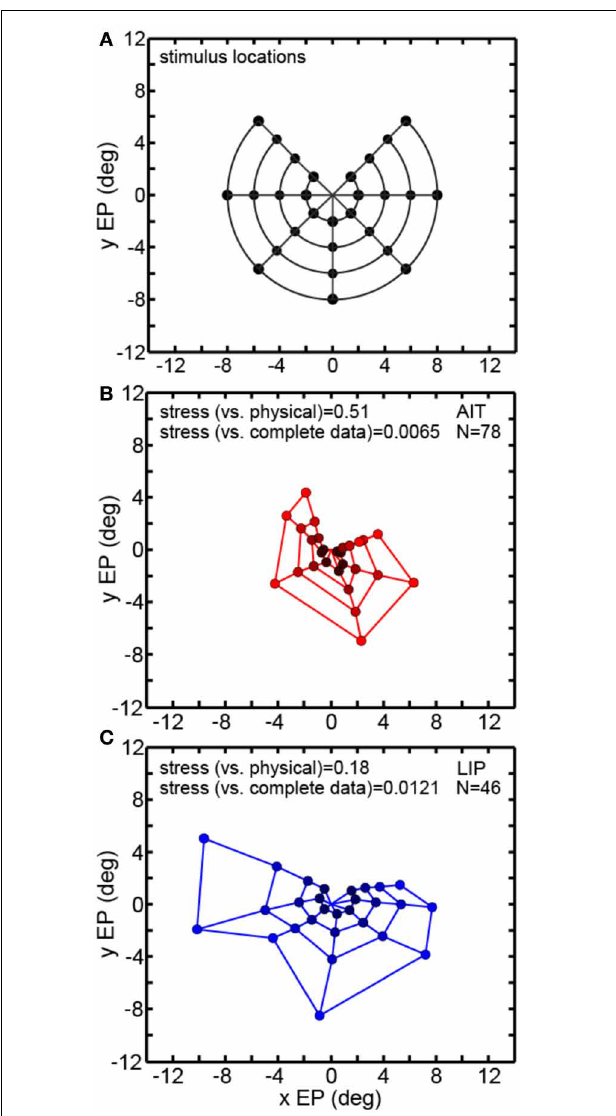
FIGURE 6 | Multidimensional scaling recovery of eye positions using a partial set of inputs. Conventions are the same as in Figure 3 . (A) Eye positions used as input configuration for MDS analysis, with one wedge or sector removed compared to the complete set shown in Figure 3A . (B) Configuration of eye positions (red points) recovered from AIT using partial data set. (C) Configuration of eye positions (blue points) recovered from LIP using partial data set. Colors darken at lower eccentricities to aid visualization. Both data panels give stress between recovered eye positions and physical eye positions, as well as stress between recovered eye positions for full and partial data sets. Small stress values between full and partial data indicate that eye position recovery is not highly sensitive to the precise composition of the global configuration used as input to MDS.